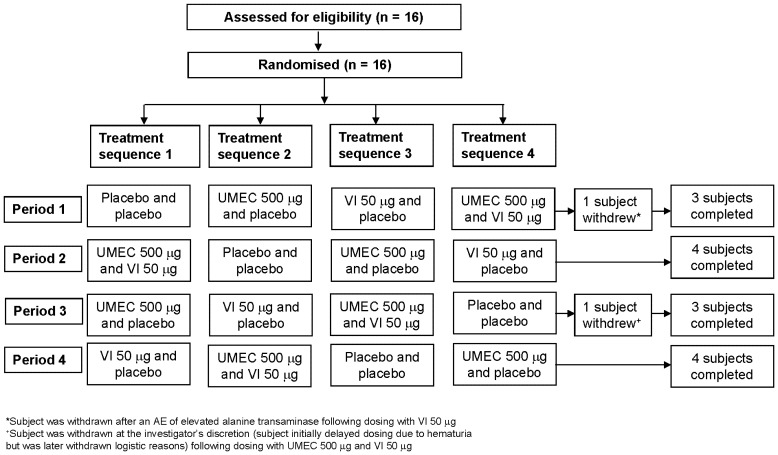
CONSORT diagram.